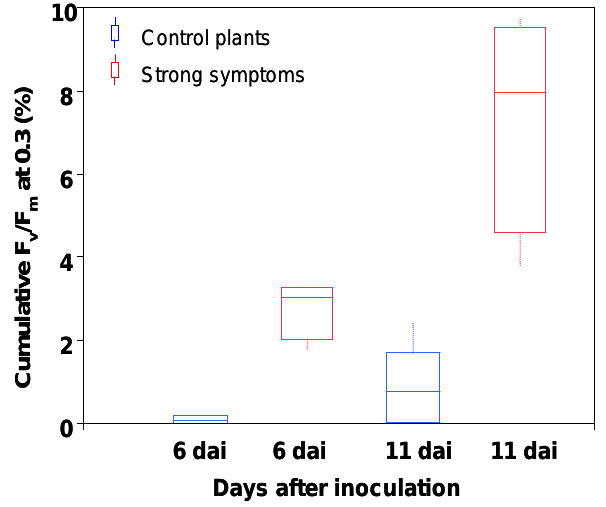
Figure 3. Cumulative F sod at dai 11) infected ears (red).